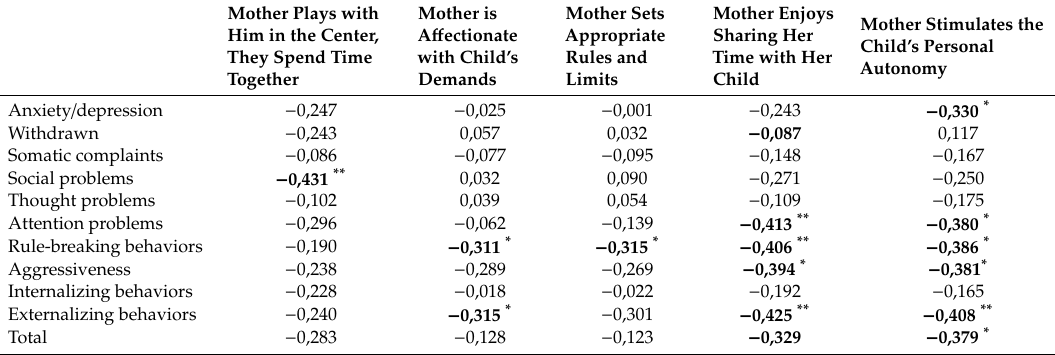
Table 3. Significant relationship between behavioral problems of children and parenting competences in